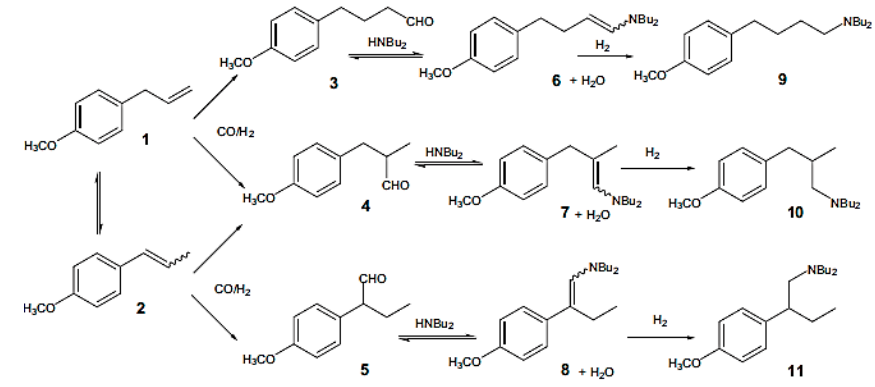
Figure 13. Hydroaminomethylation of estragole ( 1 ). Reprinted from [80] with permission from Elsevier.